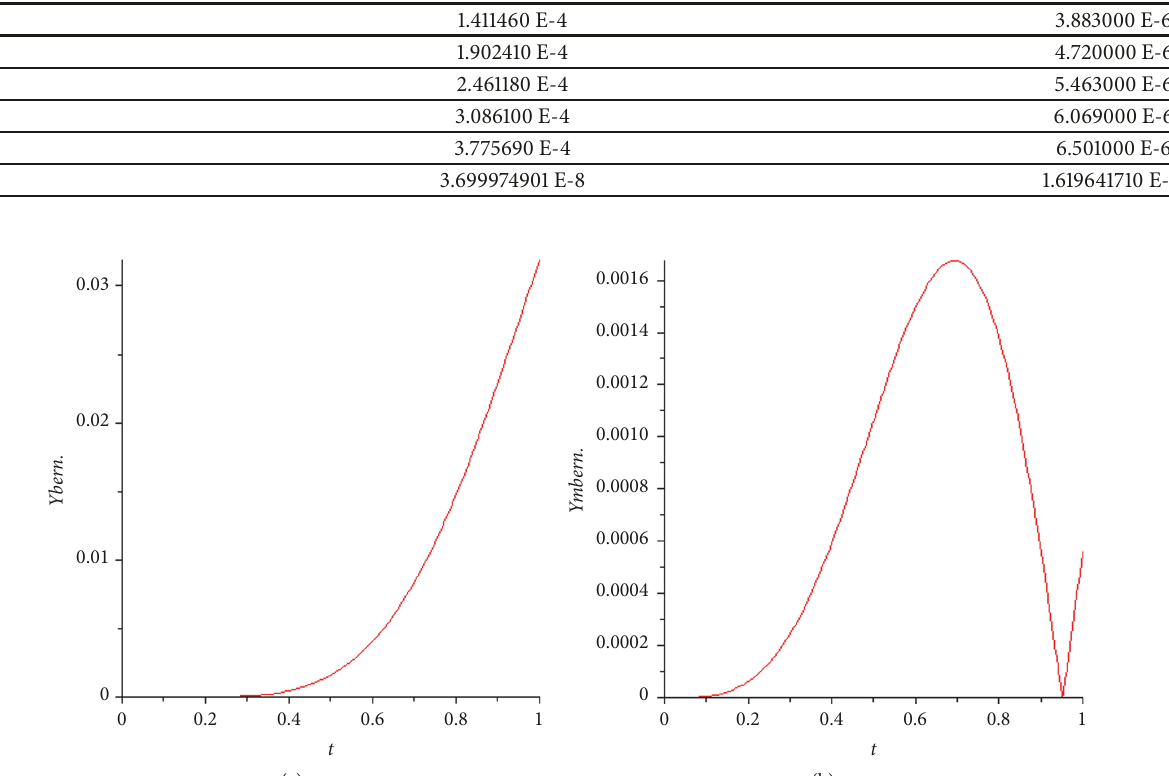
Figure 2: The absolute error between ADM with modified Bernstein polynomials and the exact solution when m=v=10 and k=3.